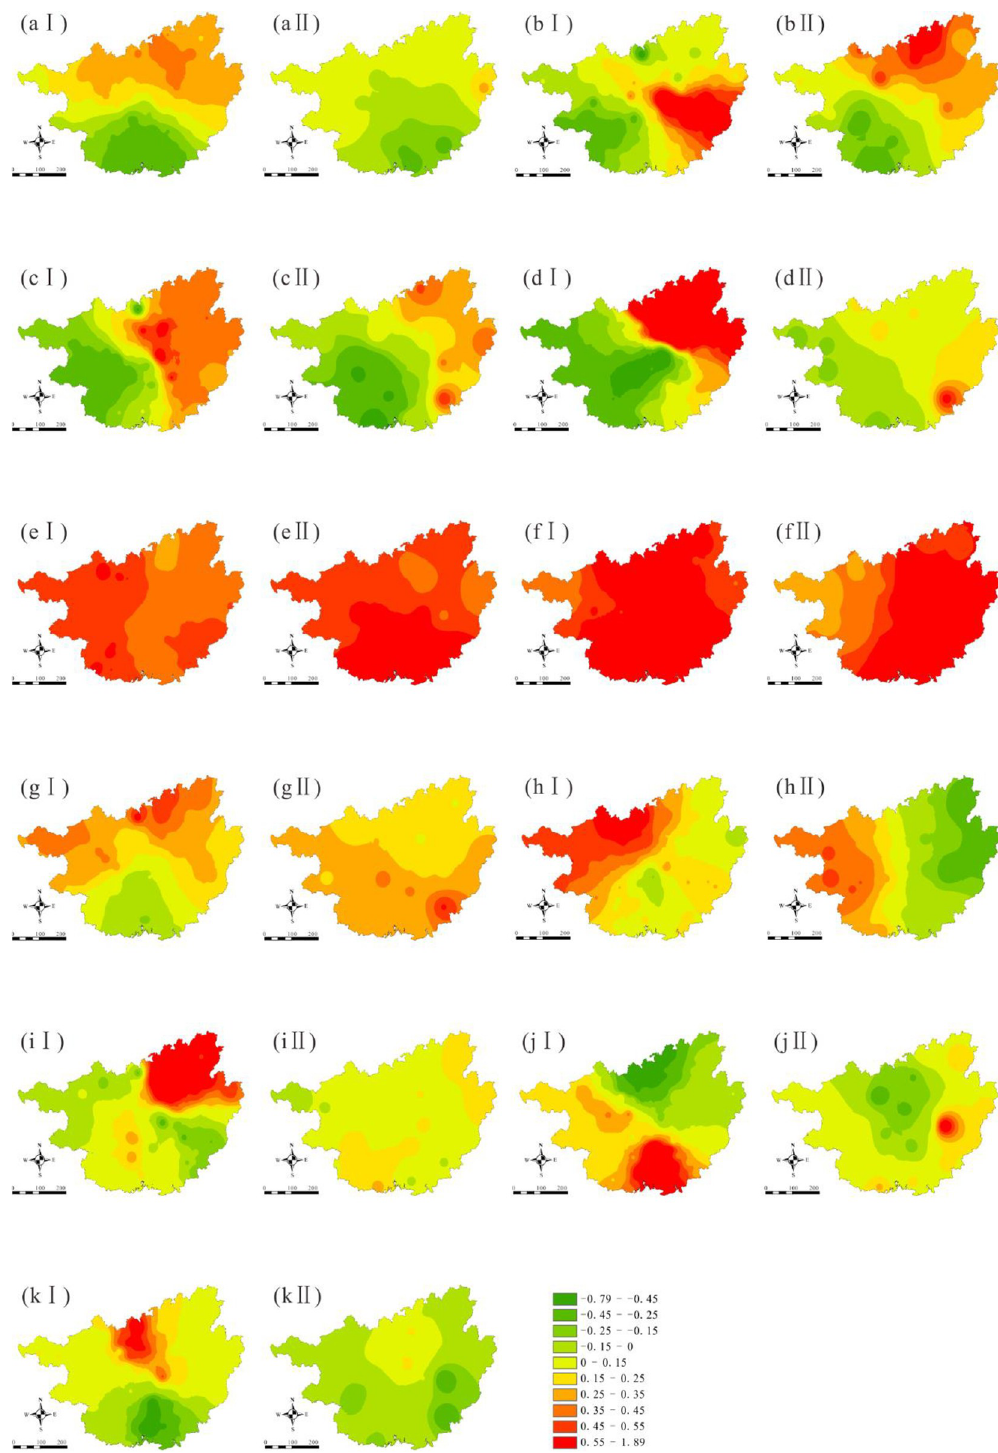
Fig 5. Spatial variability of regression coefficients in GTWR model (a: Geological background; b: Elevation; c: Temperature; d: Precipitation; e: pH; f: Corg; g: NDVI; h: deposit density; i: Industrial pollutants; j: Agricultural pollutants; k: Domestic pollutants; I for CGB I; II for CGB